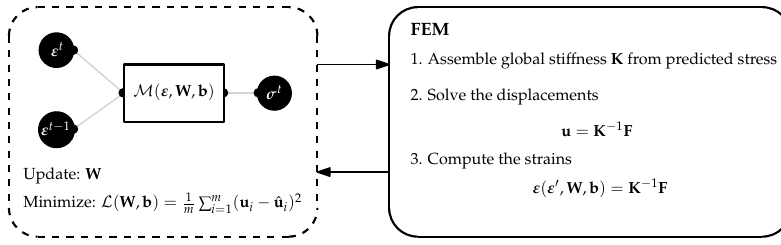
Figure 6. Coupled ANN-FEM model approach presented by Liu et al. [59].